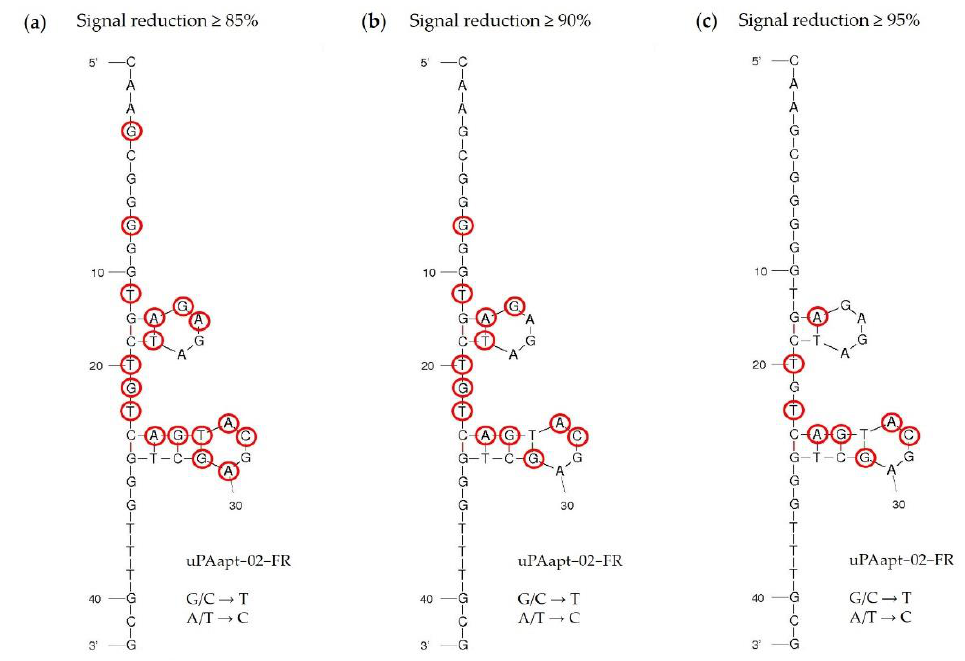
Figure 7. Secondary structure of the reporter aptamer uPAapt − 02 − FR predicted by mfold. All 42 nucleotides were replaced individually (for G/C a T and for A/T a C) and each sequence was analyzed for binding in FLAA. Exchanged nucleotides for which the resulting aptamer showed a signal reduction of ( a ) ≥ 85%, ( b ) ≥ 90%, or ( c ) ≥ 95% compared to uPAapt − 02 − FR are circled in